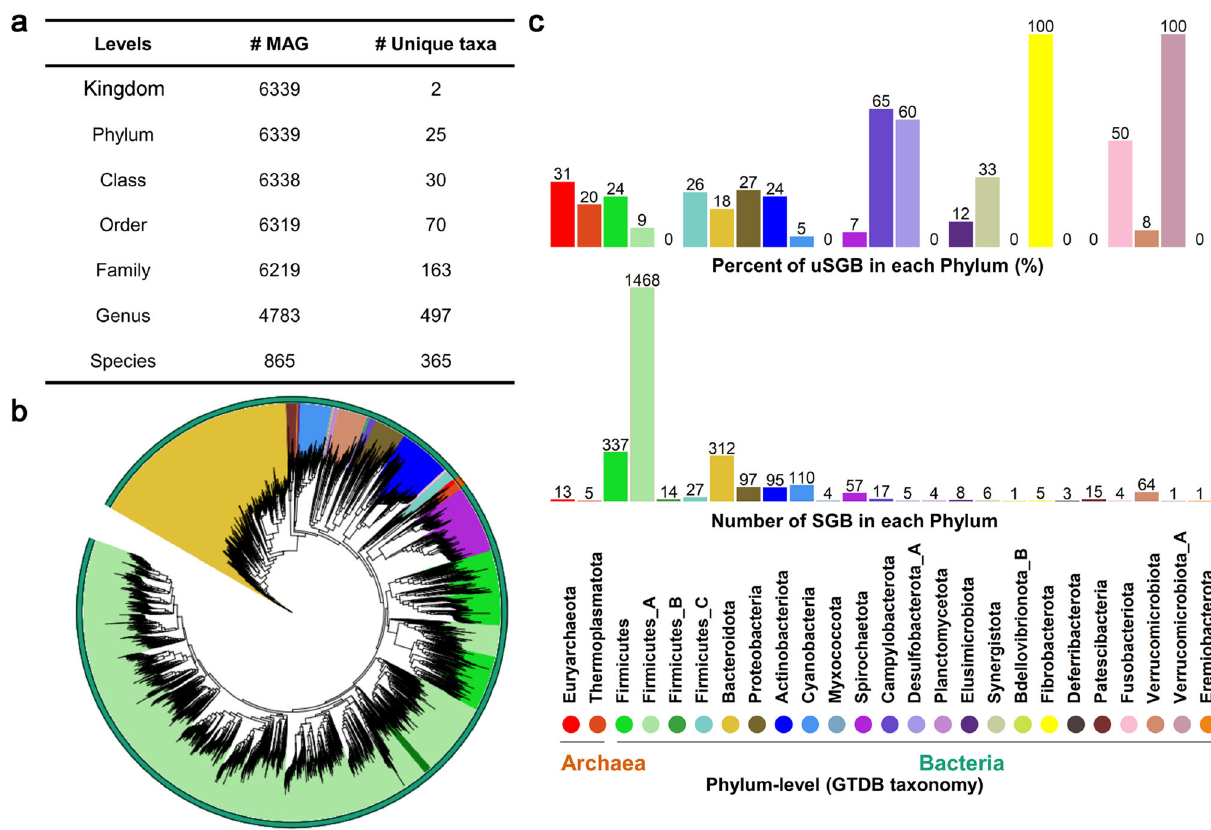
Fig. 4 Taxonomic annotation and phylogenetic tree of 6339 metagenome-assembled genomes (MAGs). a Taxonomic classi fi cation of 6339 MAGs at different levels. b Phylogenetic tree of MAGs. The outer cycle represents kingdoms and the different colors of the background of clades represent phylum. The tree was constructed by PhyloPhlAn (v3.0.51) and visualized by iTOL (v5.6.2). c The number of species-level genome bins (SGBs) and the percentage of unknown SGB (uSGB) in each phylum. Two phyla are from Archaea and the others belong to Bacteria. The SGBs without existing reference genome (could not be annotated at the species level by GTDB-tk) were de fi ned as unknown SGBs (uSGBs), while the SGBs having at least one MAG could be annotated at the species level as known SGBs (kSGBs). The color of each phylum was consistent with ( b